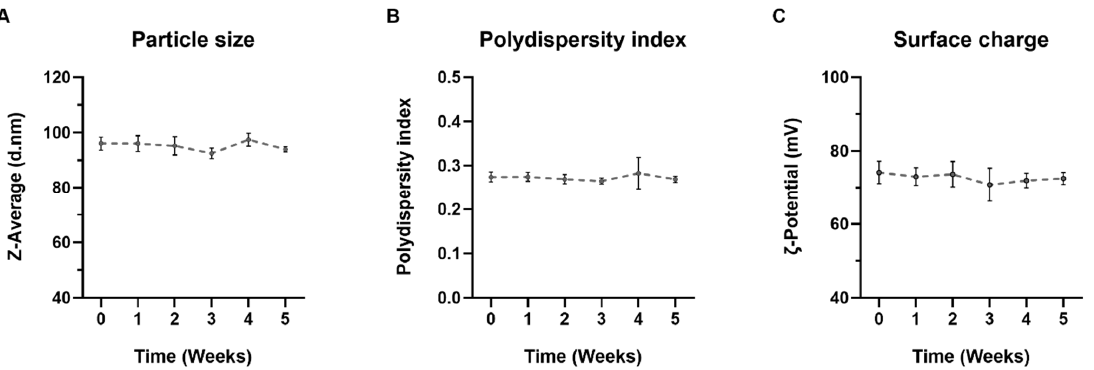
Figure 2. Five-week stability of SLNs at 4 °C. ( A ) Particle size, ( B ) polydispersity index and ( C ) surface charge of SLNs during five weeks stored at 4 °C. Results are shown as the mean ± standard deviation ( n = 3).